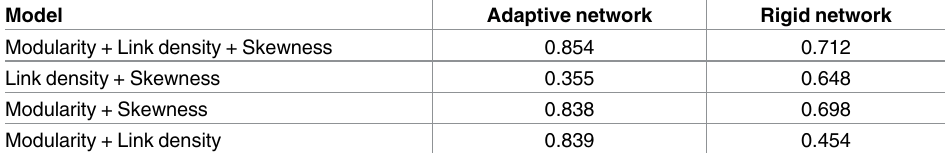
Table 2. Variance explained measuredby adjusted R 2 from the generalised additive model fitting of robustness on specific